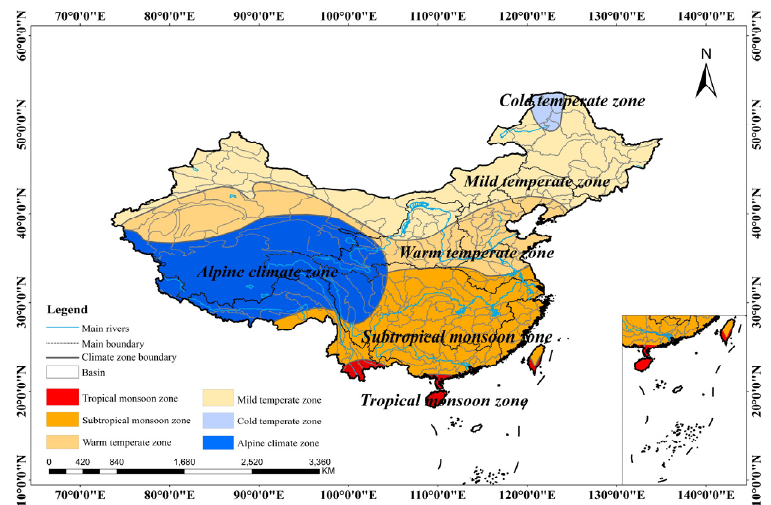
Figure 1. The distribution of 214 third-order watersheds across six climate zones in China.